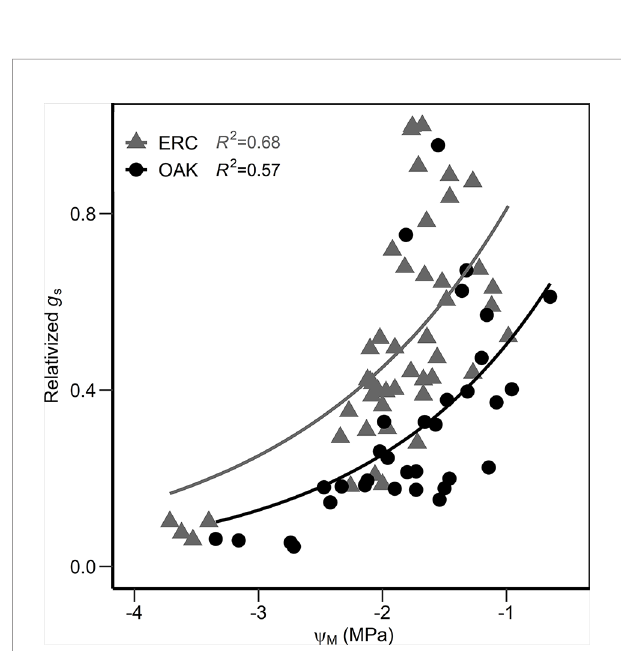
FIGURE 7 | Relationship between the relativized stomatal conductance (measured g s divided by the maximum stomatal conductance reading of each species, relativized g s ) and the midday water potential ( Y M ) for post oak (circles) and eastern redcedar (triangles). Equations are as follow: g s oak = 1.47 e 0.97 Y ; g s erc = 2.33 e 0.89 Y